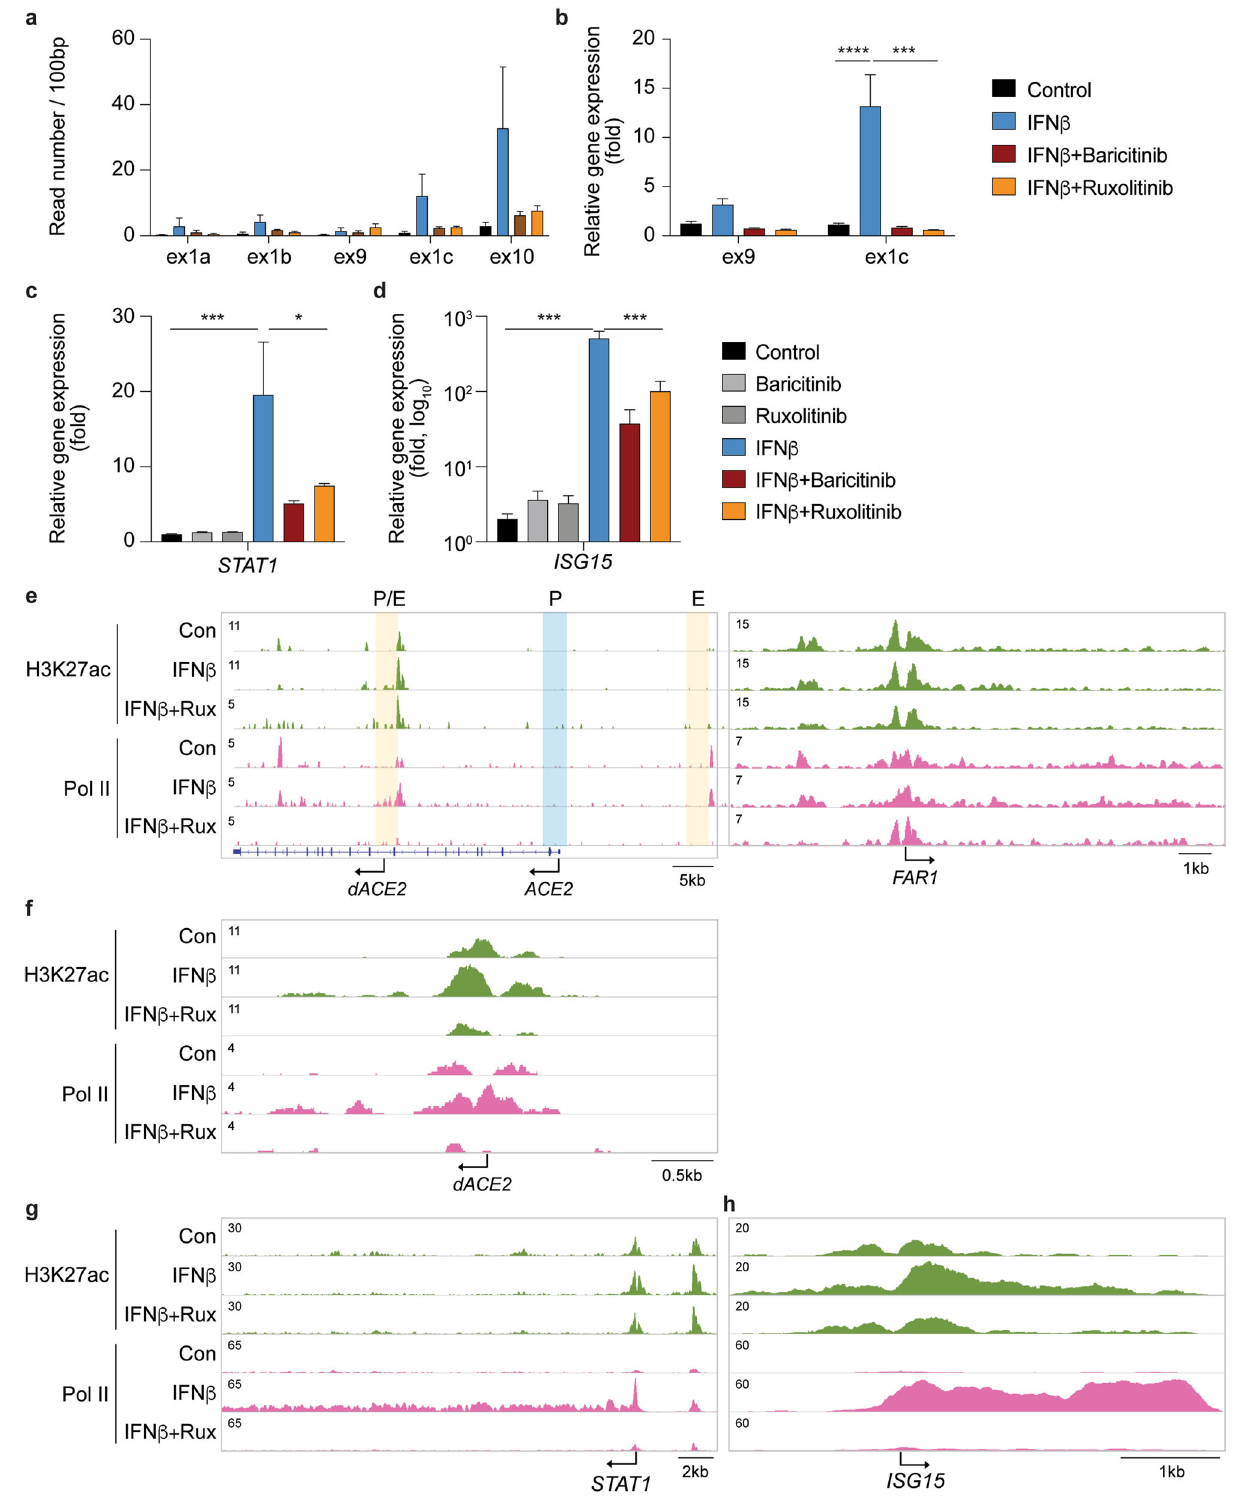
Fig. 4 JAK inhibitors mitigate activation of IFN β -stimulated genes. a – b SAECs were cultured in the presence of IFN β and JAK inhibitors, either baricitinib or ruxolitinib followed by RNA-seq analyses ( a ) and qRT-PCR ( b ). Reads covering key exons are displayed. qRT-PCR results were normalized to GAPDH levels and are shown as the means± s.e.m. of independent biological replicates (Control and IFN β , n = 9; IFN β + JAK inhibitors, n = 3). Two-way ANOVA with followed by Tukey ’ s multiple comparisons test was used to evaluate the statistical signi fi cance of differences between control and cytokine/Jak inhibitor-treated cells. c – d STAT1 and ISG15 mRNA levels from control and experimental cells were measured by RNA-seq. Results are shown as the means ± s.e.m. of independent biological replicates ( n = 3). One-way ANOVA with followed by Dunnett ’ s multiple comparisons test was used to evaluate the statistical signi fi cance of differences between control and cytokine/JAK inhibitor-treated cells. e – h H3K27ac marks, and Pol II loading at the ACE2 , STAT1 , and ISG15 loci in SAECs in the absence and presence of IFN β and the JAK inhibitor, ruxolitinib. The FAR1 locus was used as a ChIP-seq